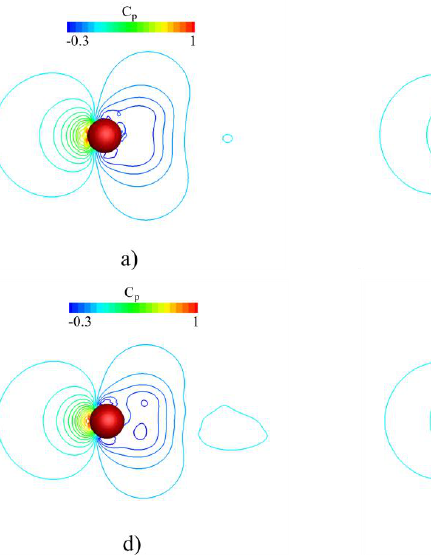
Figure 7. Time-averaged pressure coefficient distributions: ( a ) Re300D010U, ( b ) R300D005U, ( c )